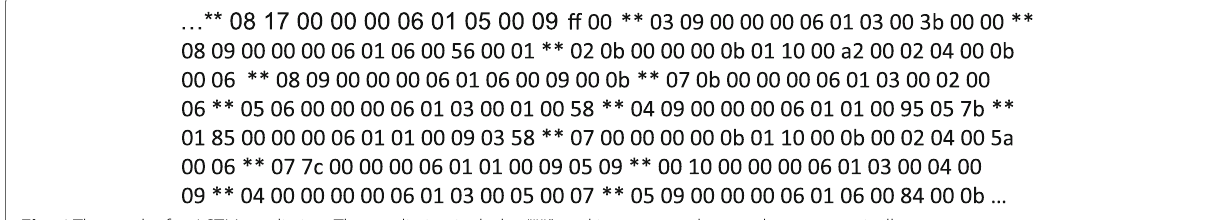
Fig. 6 The result after LSTM prediction. The prediction includes “**”, and it separates the test data